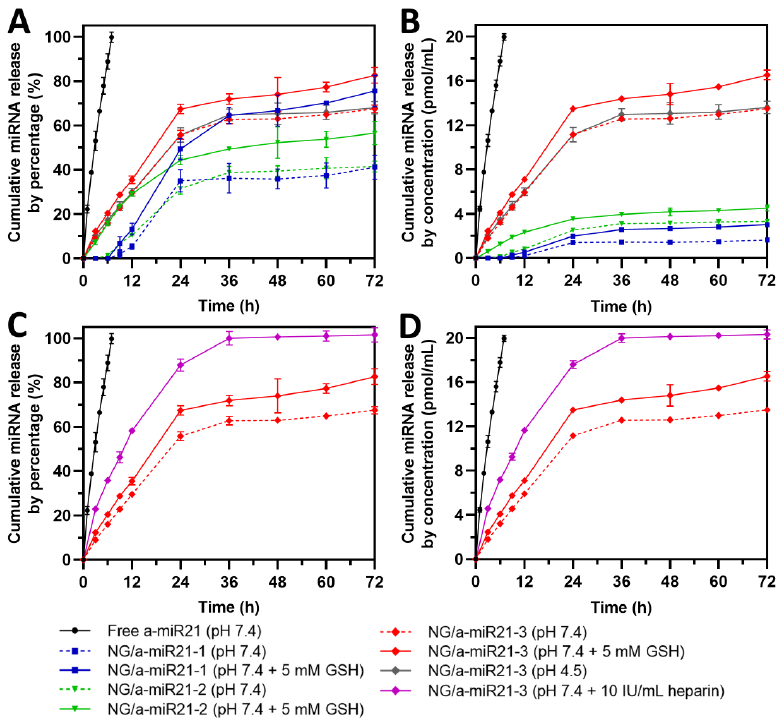
Figure 5. miRNA release profile by ( A , C ) percentage and ( B , D ) concentration from NG/a-miR21-1,2,3 at a nanogel concentration of 100 µ g/mL with or without GSH treatment (5 mM GSH) in PBS (pH 7.4) at 37 ◦ C for 72 h. NG/a-miR21-3 was also incubated in PBS (pH 4.5) and heparin-containing PBS (pH 7.4) at a concentration of 10 IU/mL. Free a-miR21 was equal to a-miR21 content in NG/a-miR21-3 to check the suitability of miRNA dialysis using a membrane with a molecular weight cutoff (MWCO) of ~100 kDa. Data are reported as the mean ± SD (n = 4). After 24 h, miRNA release from NG/a-miR21-1,2,3 reached 35.0%, 31.6%, and 55.8%,